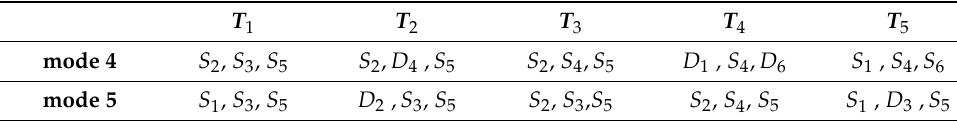
Table 5. Switching states in modes (4) and (5).